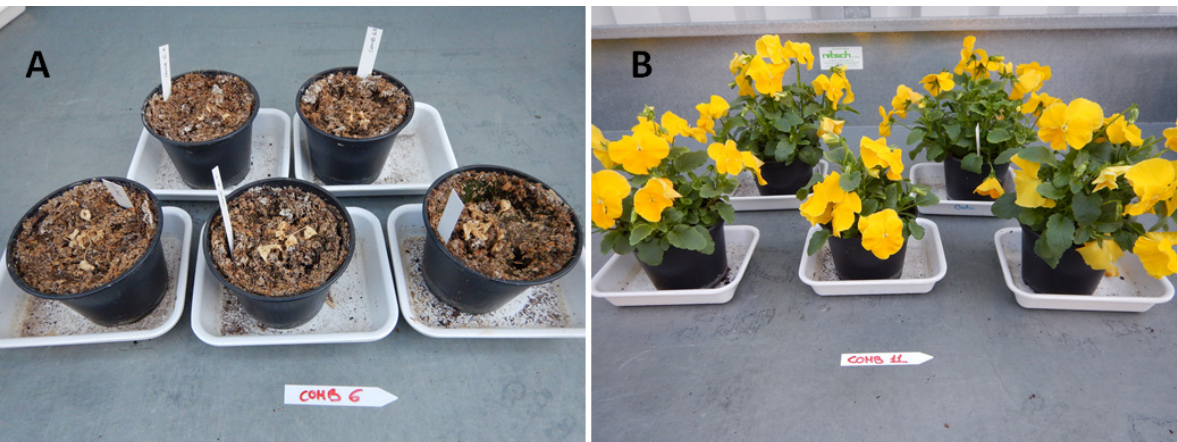
Figure 2. ( A ): Appearance of viola plants ( Viola x wittrockiana L.) growing under blend 6 (treated with ammonium sulphate). ( B ): viola plants ( Viola x wittrockiana L.) growing under blend 11 (with ammonium nitrate).